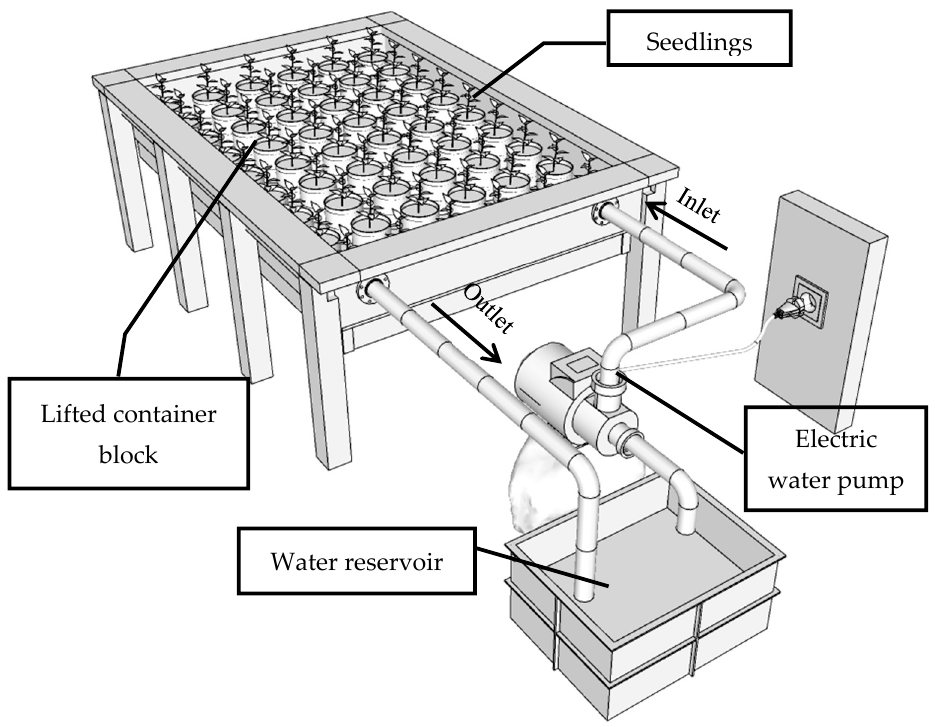
Figure 1. Equipment for propagation of Avicennia marina (Forssk.) Vierh. with varying media and salinity, showing the mechanism of water circulation in a container block of each salinity type using an electric water pump and inlet–outlet pipes. Table 1. Physical and chemical compositions of media used for propagation of Avicennia marina (Forssk.) Vierh. seedlings in an ex situ